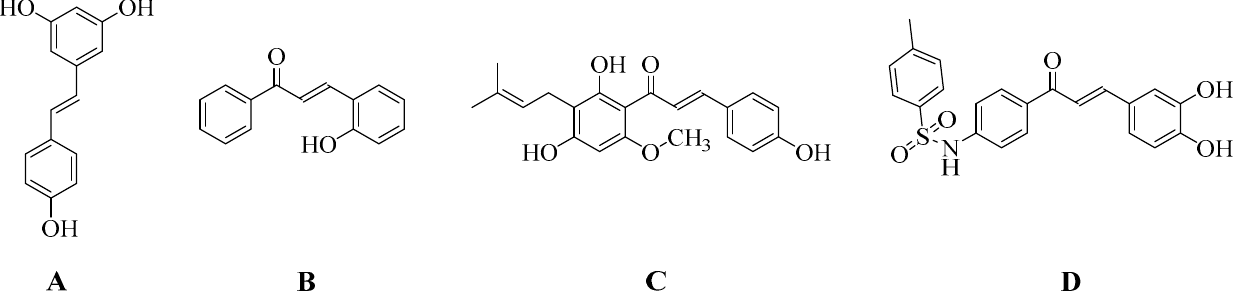
Figure 1. Structures of resveratrol ( A ), hydroxychalcones ( B , C ) and 4-( p -toluenesulfonamide)chalcone ( D ) with antihyperglycemic properties.